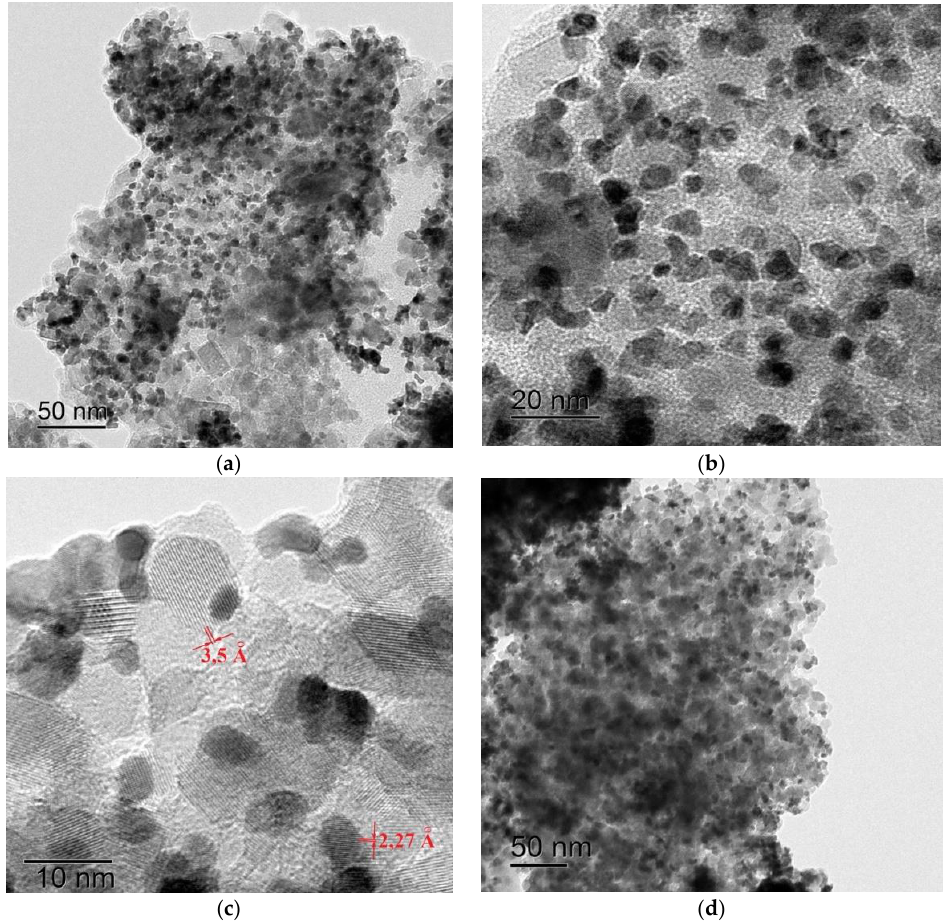
Figure 3. TEM images of Pt–Rh/Ti(Nb)O 2 ( a – c ) and Cu–Ni/Zr(Nb)O 2 ( d ) samples. Table 1. Composition, designation, particle size and surface area of the obtained